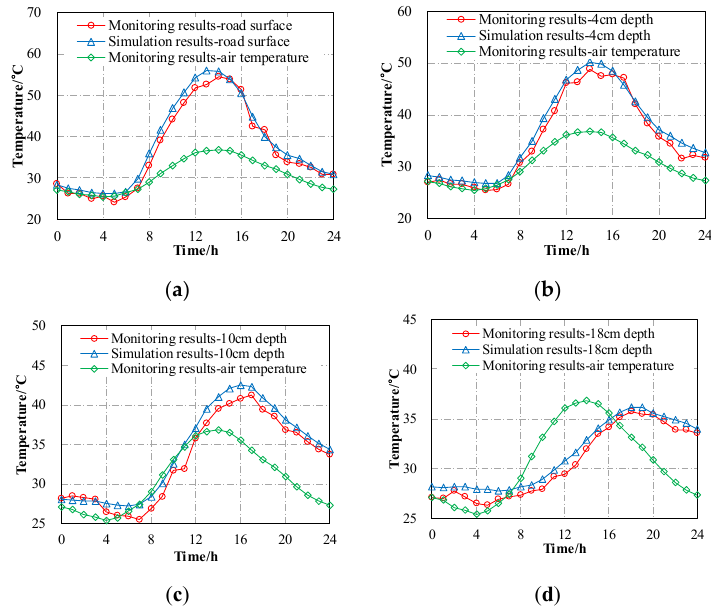
Figure 8. Simulation results compared with the monitoring results: ( a ) Road surface; ( b ) 4 cm depth; ( c ) 10 cm depth; ( d ) 18 cm depth.